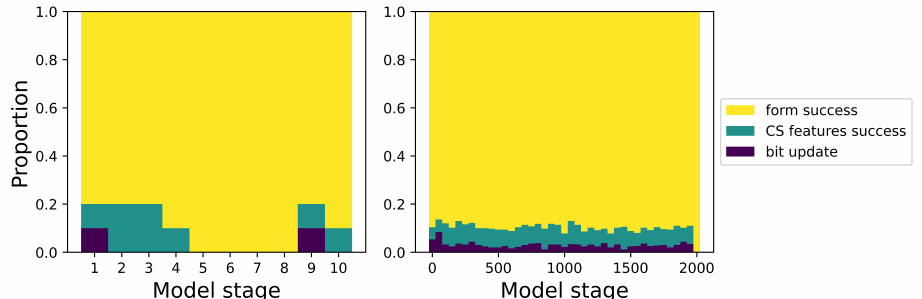
Figure 7. The proportion of language game results (form success, culturally salient features success or bit update) with 10 agents all belonging to the same group ( n_groups = 1) for the first 10 model stages ( left ) and over the 2000 stages ( right ). At each stage, 10 language games were played. The x-axis starts at stage one because in stage zero there is only model set up and no language game. Across all stages of this run, the majority of the language games end with form success, with a small proportion ending with culturally salient features success (here abbreviated as CS features success). Over 2000 stages, shown on the right, the results were averaged over 50 consecutive model stages (i.e., each bar of the histogram represents the mean of 50